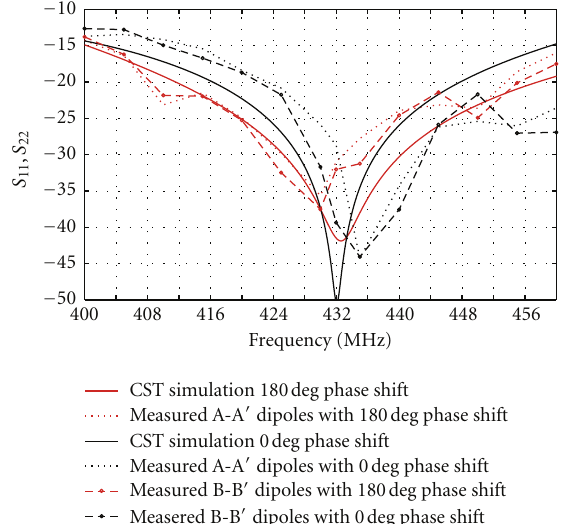
Figure 12: Measured and simulated return loss for 434MHz